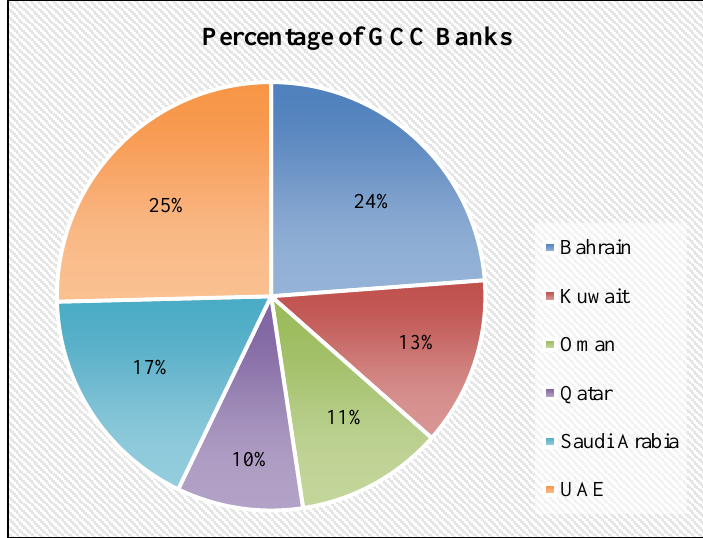
Figure 2. Number of banks per each GCC country in this